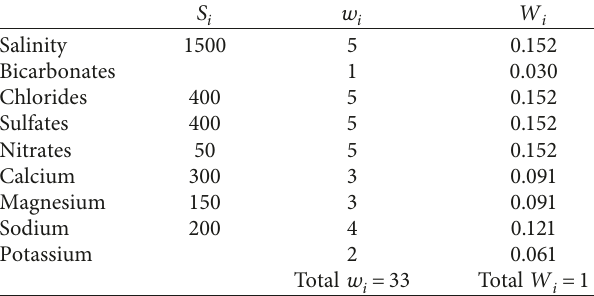
Table 3: Weight and relative weight of chemical parameters used for WQI computation.